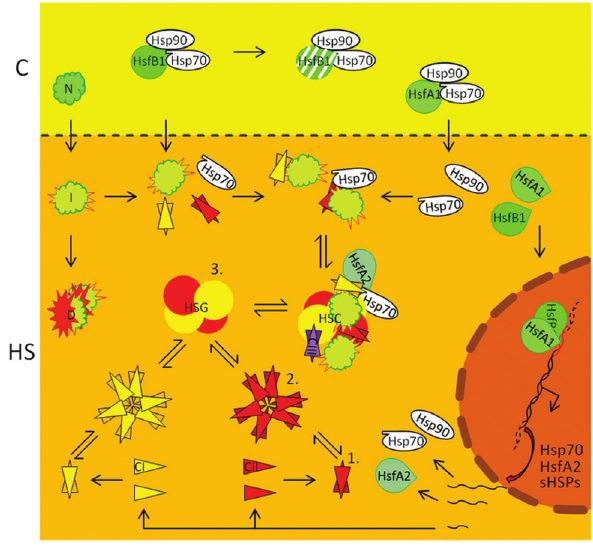
Figure 1 Schematic model of HSG and HSC formation and their influence on